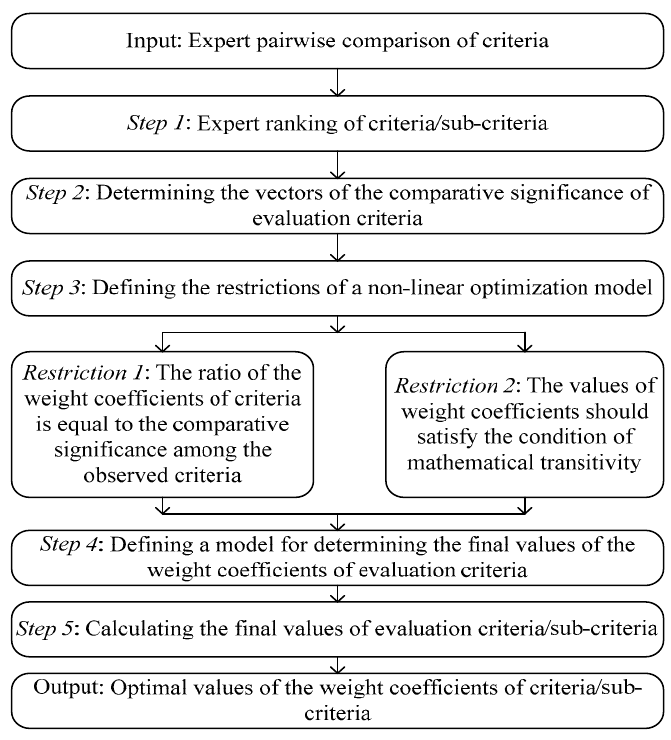
Figure 2. Algorithms of FUCOM method.